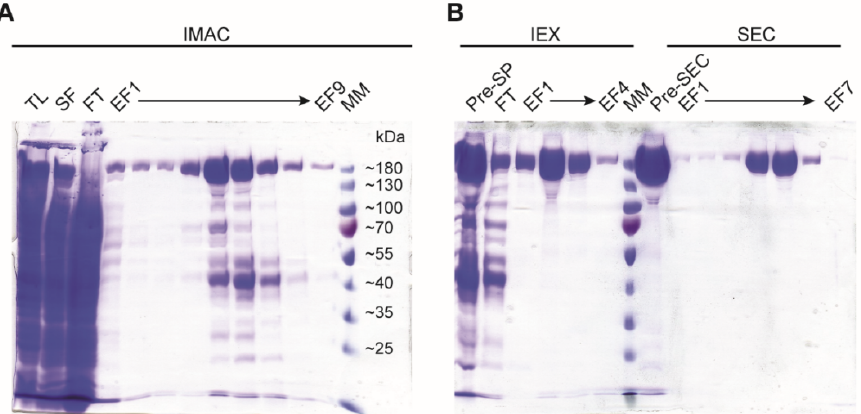
Figure 3. SDS-PAGE run on 10% acrylamide-bisacrylamide gel. ( A ) IMAC protein samples. ( B )